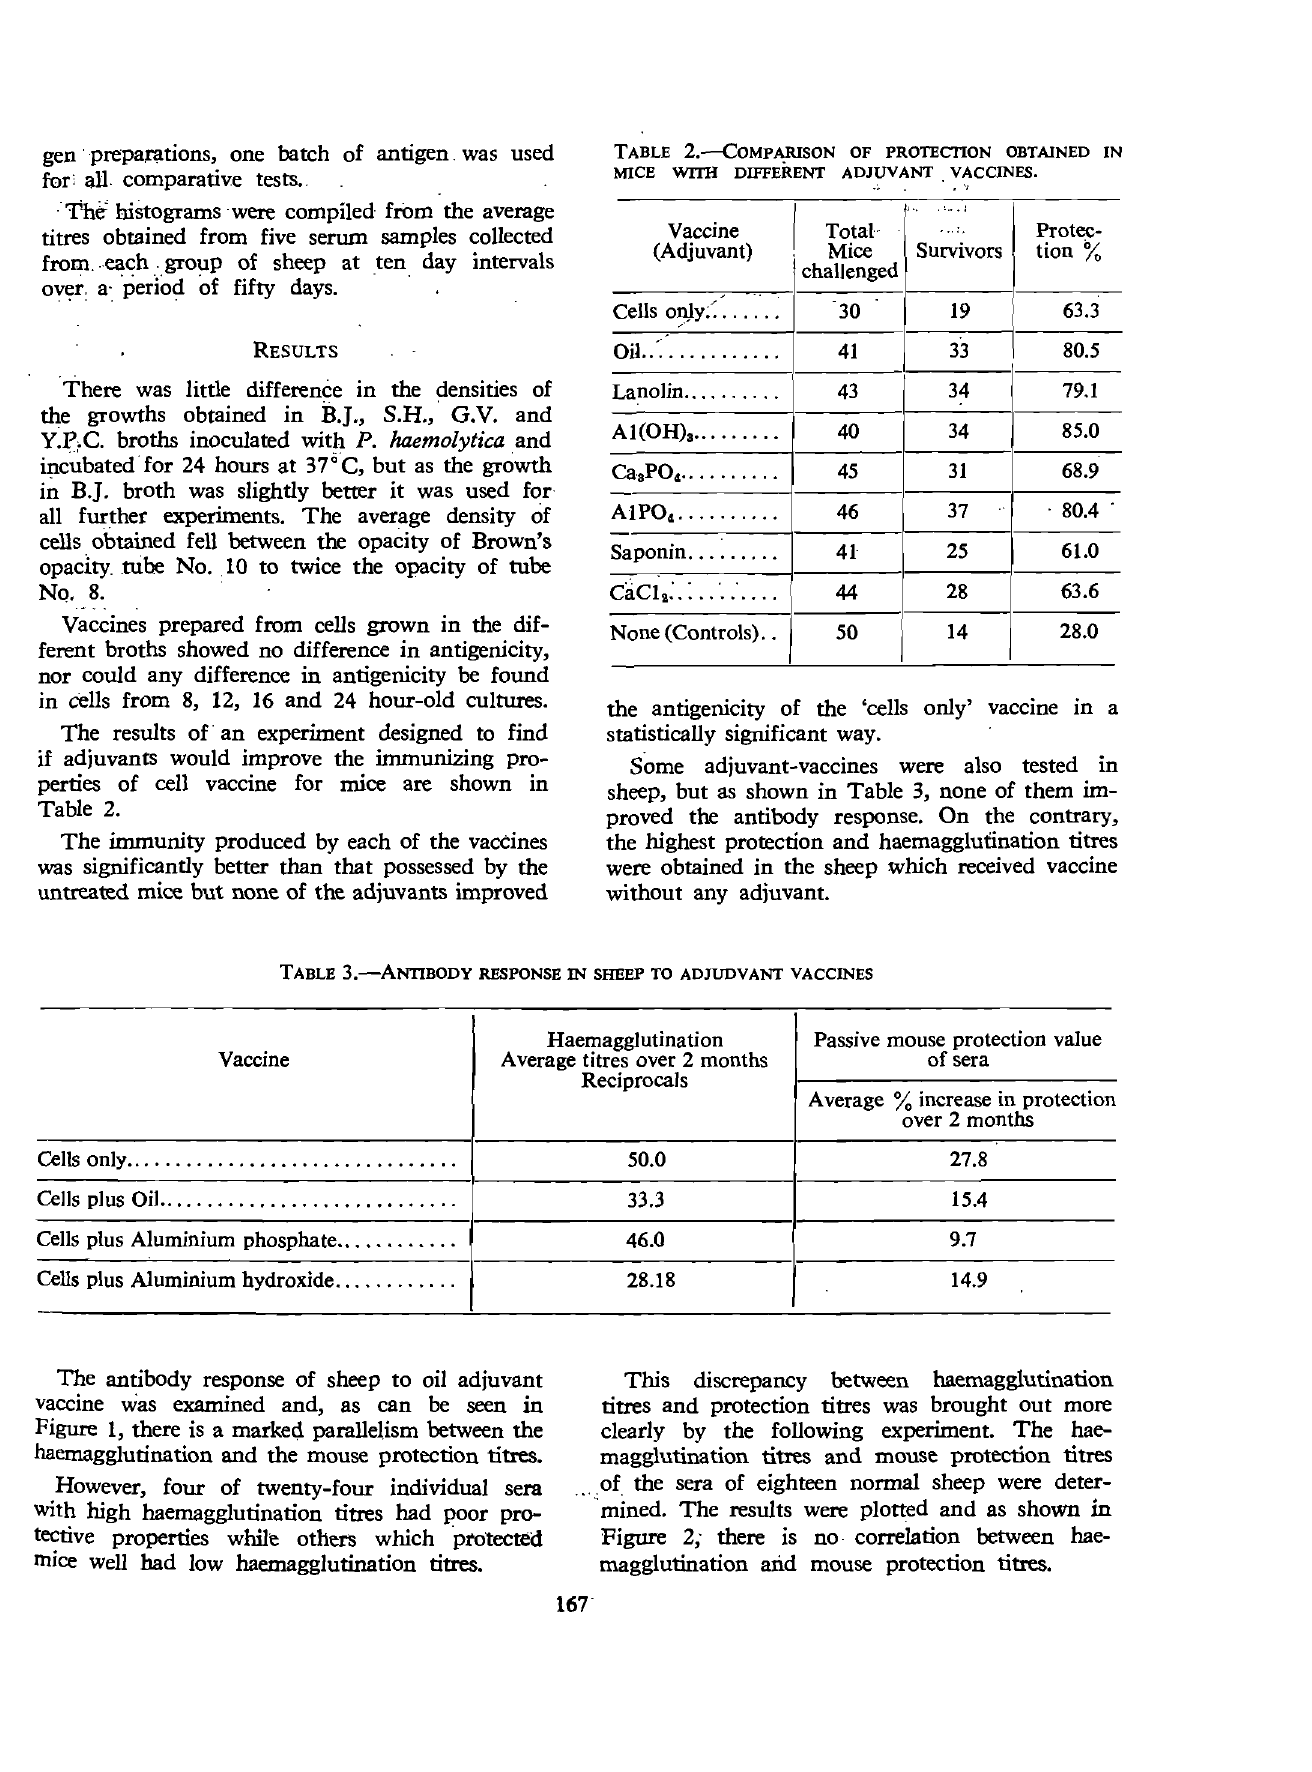
TABLE 2.---COMP~SON OF PROTECTION OBTAINED IN MICE WITH DIFFERENT ADJUVANT VACCINES. Vaccine (Adjuvant)